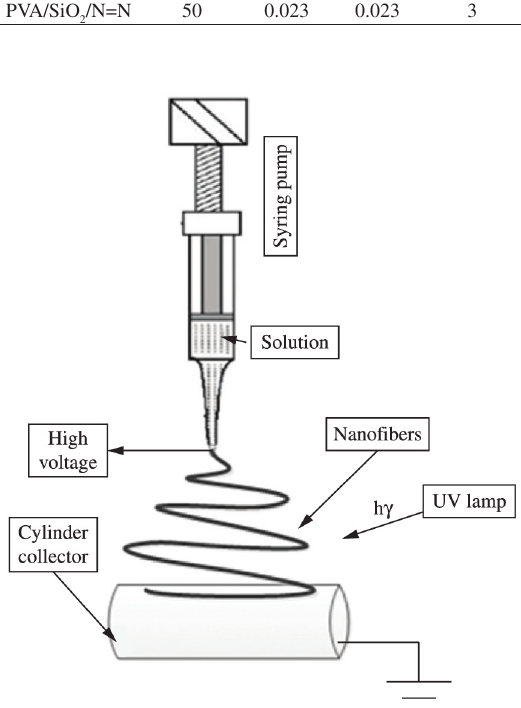
Figure 1. Schematic diagram of electrospinning process.